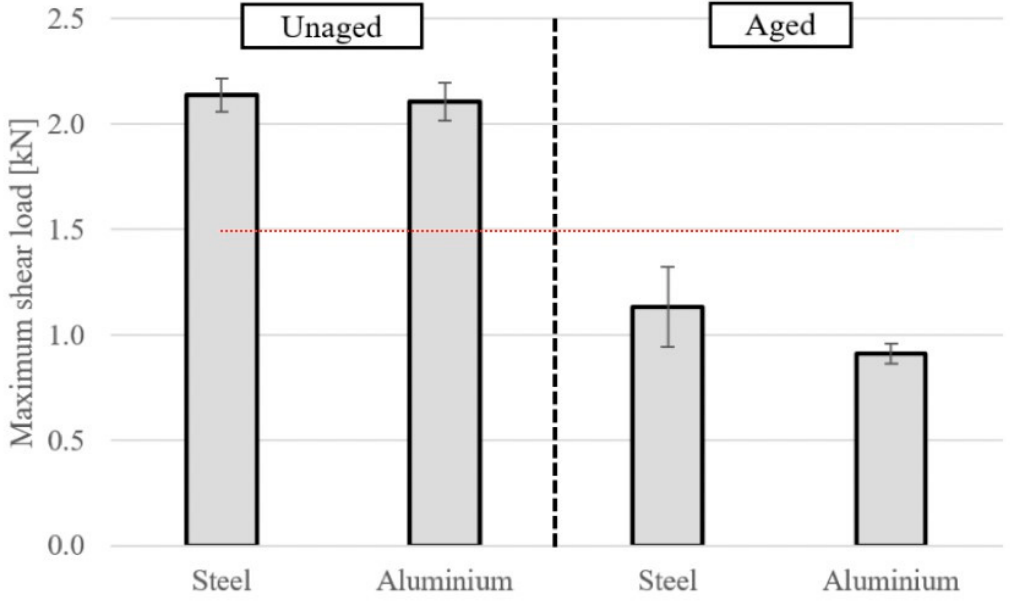
Figure 12. Maximum shear strength of RJS specimens in unaged and aged (in water) conditions. The red dotted line represents the threshold value for the RJS specimen’s minimum allowed joint strength (1.5 kN).